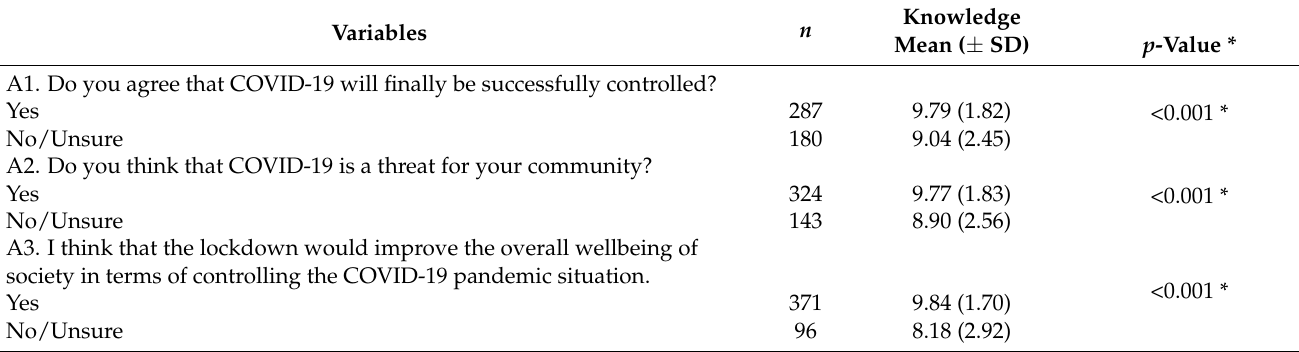
Table 5. Association between knowledge and attitudes.